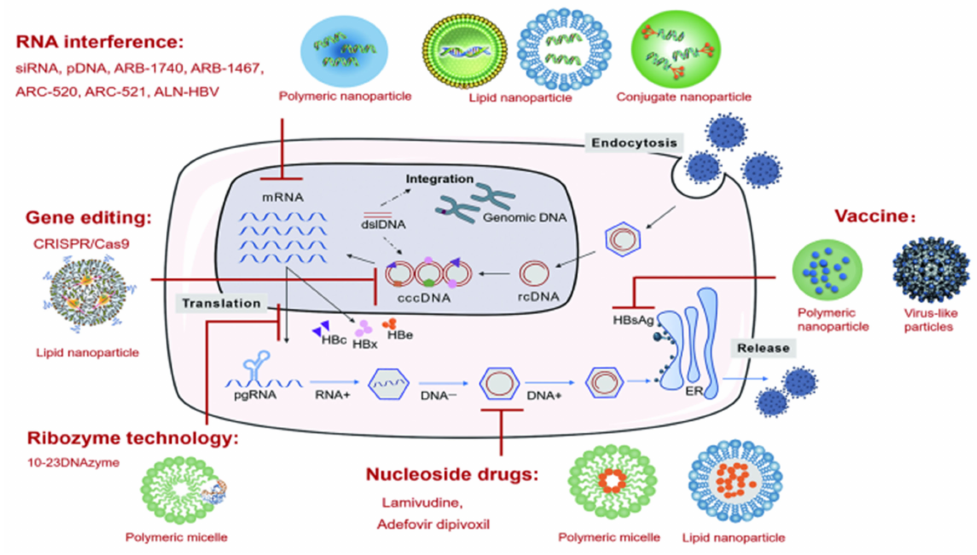
Figure 2. Types of nanoparticle delivery systems for anti-HBV